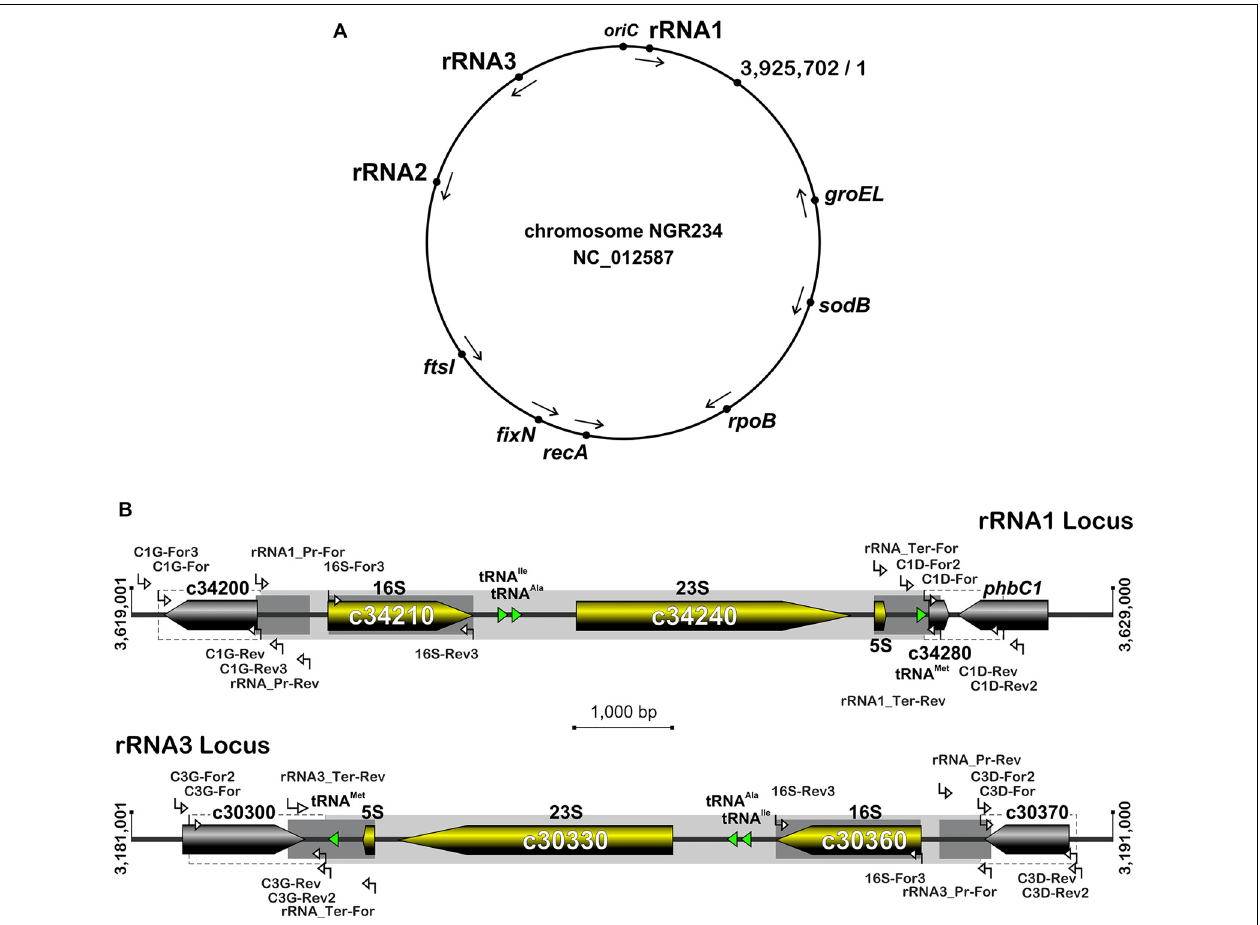
FIGURE 1 | Organization of rRNA operons on NGR234 chromosome and detailed genetic maps of the rRNA1 and rRNA3 loci. (A) Circular map of the 3.9 Mb chromosome of NGR234 with the positions and orientations of the three rRNA operons as reported in the accession number NC_012587 (Schmeisser et al., 2009). (B) Detailed genetic maps of the rRNA1 and rRNA3 operons: Genes coding for 5S, 16S, and 23S rRNA subunits are shown as yellow arrows oriented according to transcription, while genes predicted to code for proteins are shaded in gray and those for tRNAs depicted as green triangles. The section of each operon that was replaced by Omega is shaded in gray. Segments of the 16S genes, promoters, and terminators that were verified by sequencing cosmid DNAs are highlighted in darker shades of gray. Regions flanking the deleted rRNA operons and used as sites for homologous recombination are delimited by dashed lines. Small and labeled white arrows represent the positions and orientations of primers used in this